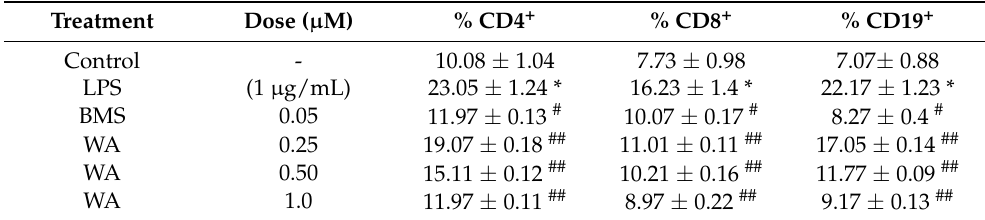
Table 1. Immunomodulatory effect of WA on LPS-stimulated splenocytes derived from BALB/c mice. Experimental data presented as the mean ± SEM of three or more independent experiments. * p ≤ 0.05 (comparison vs. LPS only), # p ≤ 0.05, and ## p ≤ 0.01 (comparison vs. + LPS) are statistically